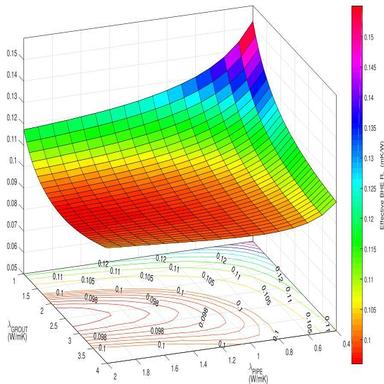
Graphic showing the simultaneous effect of varying the lPIPE and lGROUT in the Rb of a designed system for an office building in a hot region with medium thermal conductivity of the ground. Isolines are spaced 0.0005 mK/W until 0.1 mK/W and 0.005 mK/W from that value to 0.15 mK/W.